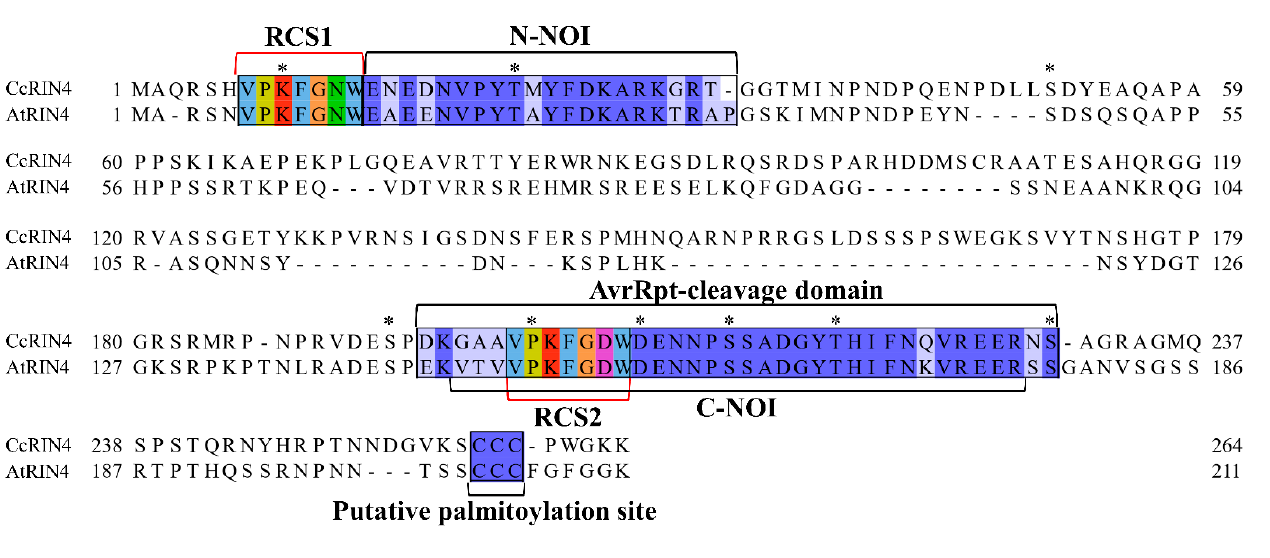
Figure 1. Sequence comparison analysis result of Arabidopsis and Citrus clementina RIN4 proteins.